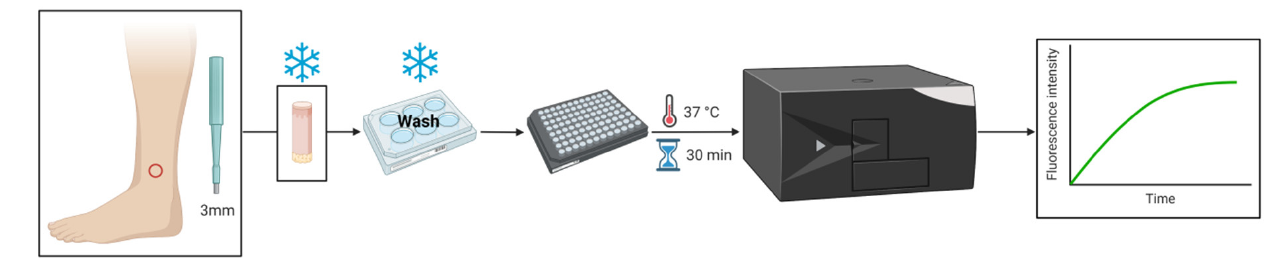
Figure 5. Thrombin activity in human skin—method flow diagram: For measuring thrombin activity in human skin, a 3 mm punch was obtained from the leg (10 cm above the lateral malleolus) and transferred to −80 °C until the thrombin activity assay. The biopsy was thawed and washed 3 times for 5 min on ice. Following this, it was placed in a 96-well black plate and incubated at 37 °C for 30 min. After incubation, a specific thrombin substrate was added and the fluorescence intensity over time was measured. Created with BioRender.com (accessed on 25 November 2021).